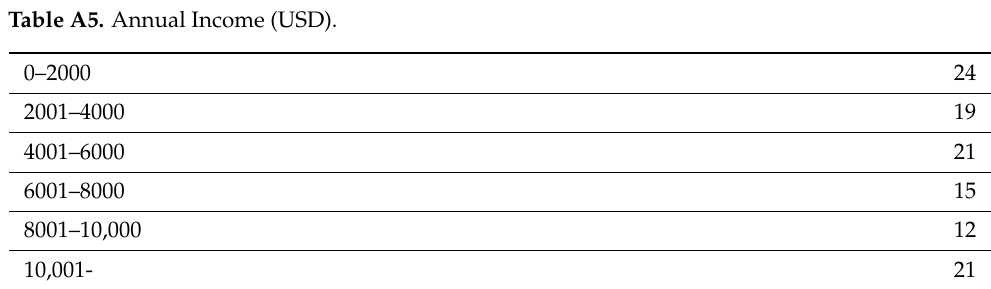
Table A5. Annual Income